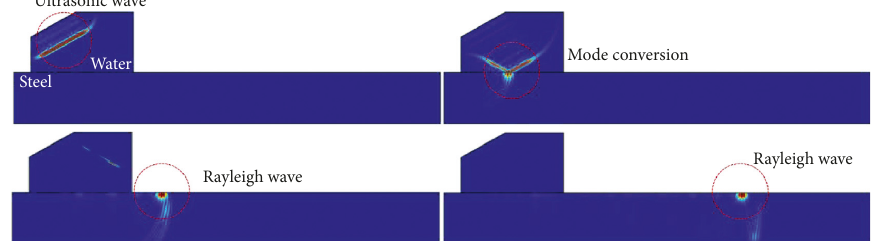
Figure 3: Simulation result of Rayleigh wave